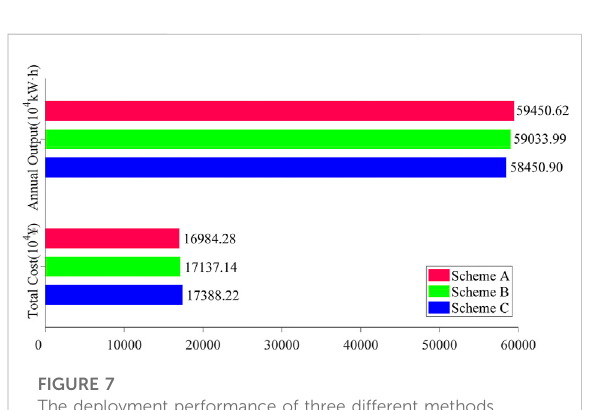
FIGURE 7 The deployment performance of three different